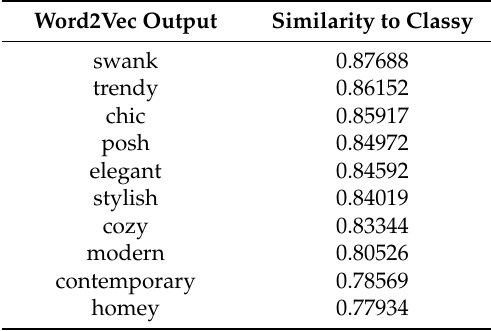
Table 2. Top 10 most similar words to